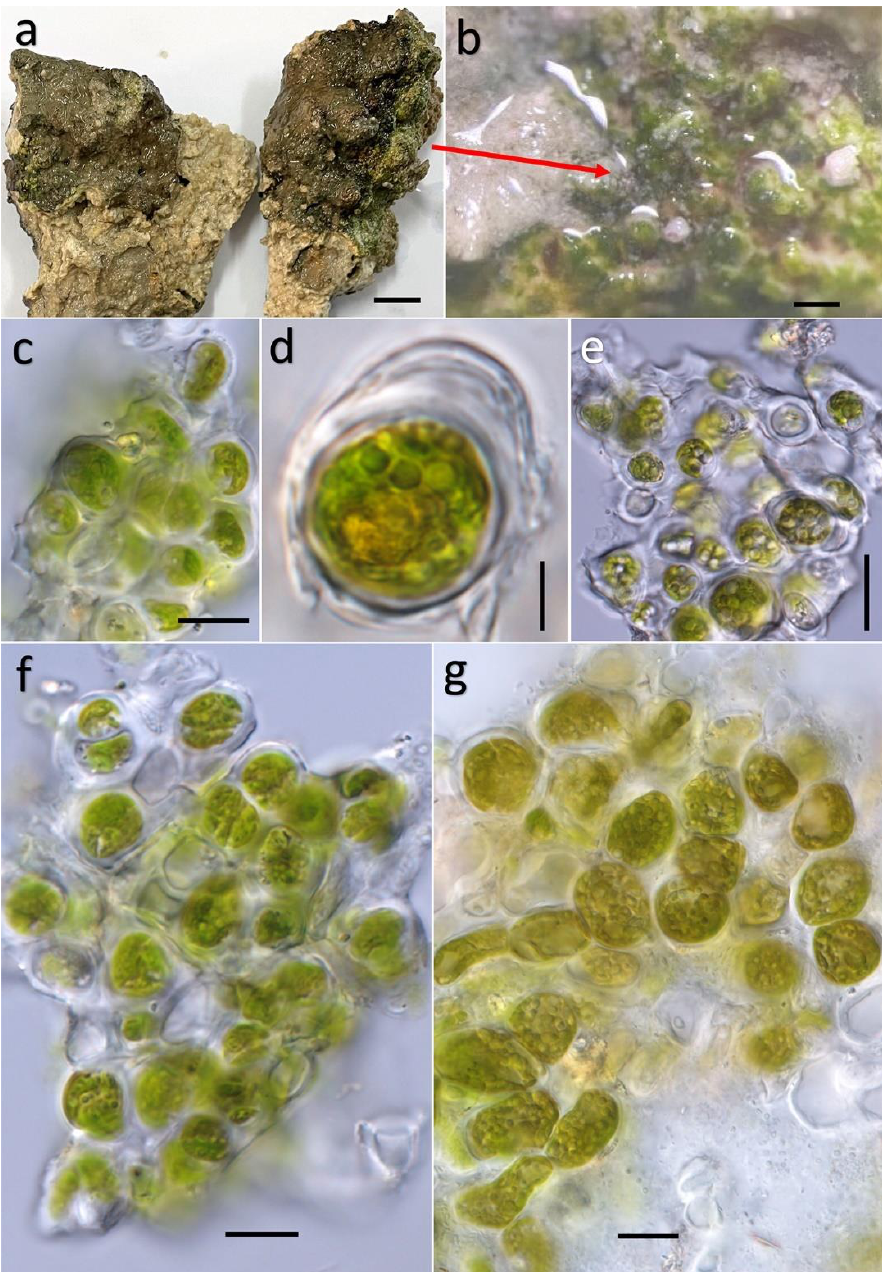
Figure 2. Field sample morphology of Ulvella lacustris sp. nov.: ( a ) Habitat of Ulvella lacustris , growing on rough rock at the bottom of the lake; ( b ) Natural thallus on surface of rock under stereoscopy; ( c ) The cell arrangement was dense and the cell shape was severely compacted; ( d ) Single cell, with significantly thicker cell wall and integument; ( e ) The plant body is pseudoparenchyma-like, with thick integument and cell wall; ( f ) The color of young cells is green, and the gelatinous envelope is obvious; ( g ) The color of mature cells is yellow, and the gelatinous envelope is not obvious. Scale bar: 1 cm ( a ), 0.25 cm ( b ), 10 μm ( c , f , g ), 5 μm ( d ), 20 μm ( e ).